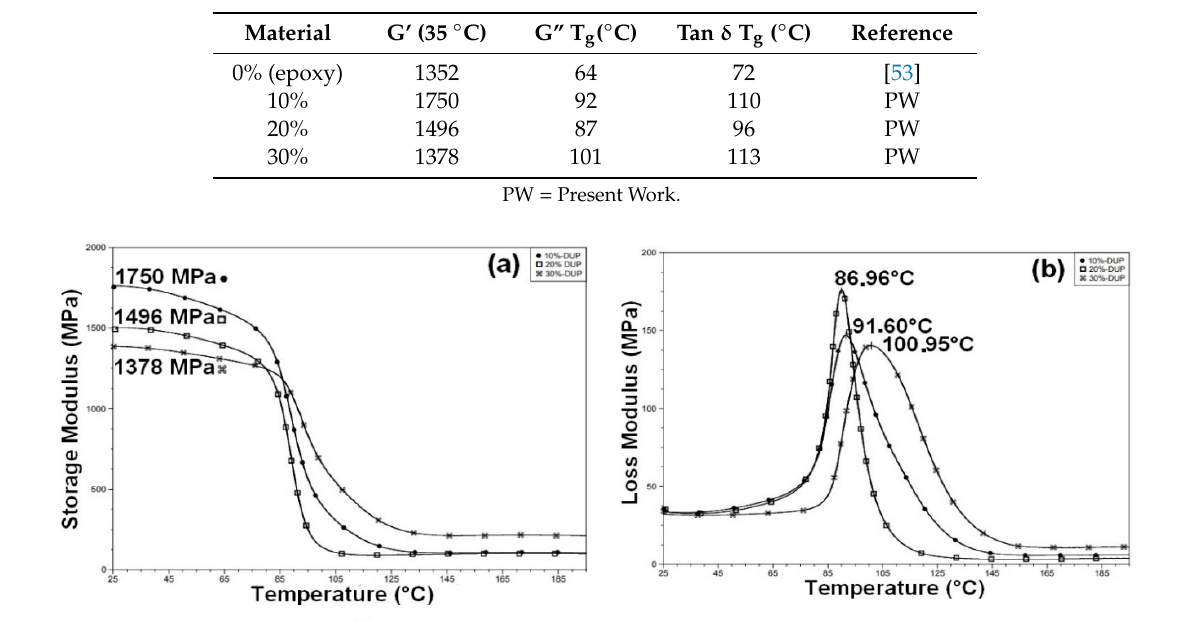
Table 6. DMA parameters.